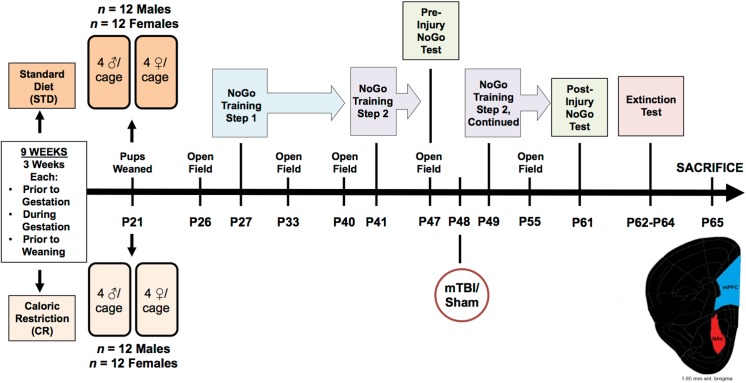
Illustrative representation of the experimental paradigm, which includes the age that each rat underwent behavioural testing, mTBI, and sacrifice.